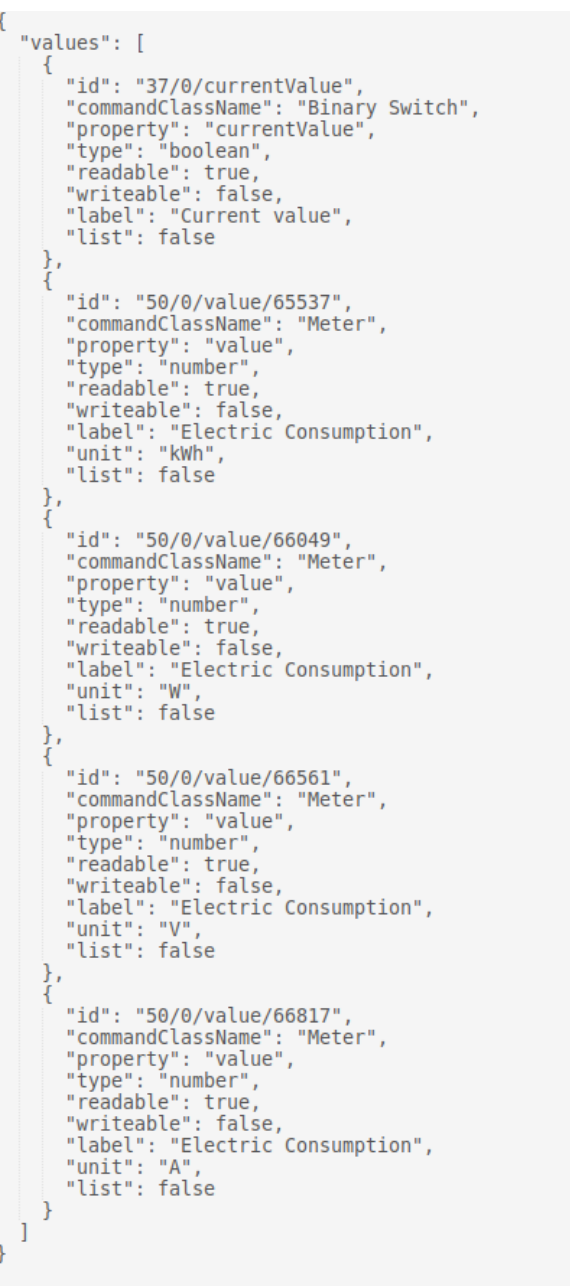
Figure 5. Z-Wave smart